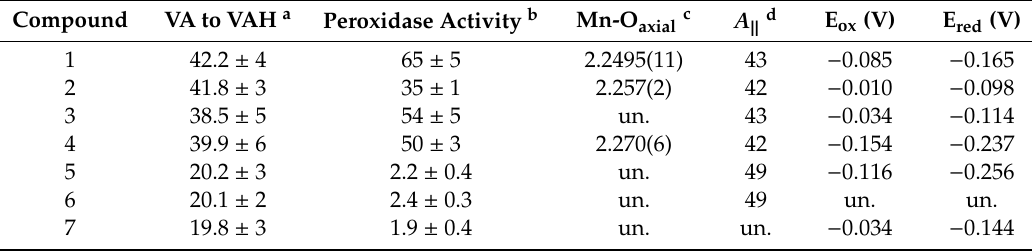
Table 3. VA to VAH conversion, peroxidase activity, Mn-O axial distances, EPR hyperfine coupling and redox potentials for the complexes.